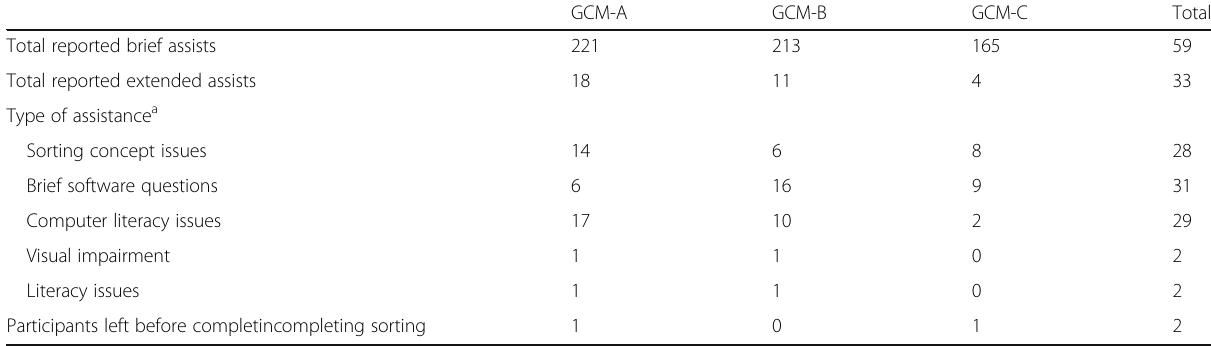
Table 2 Research Team Interactions with GCM Participants